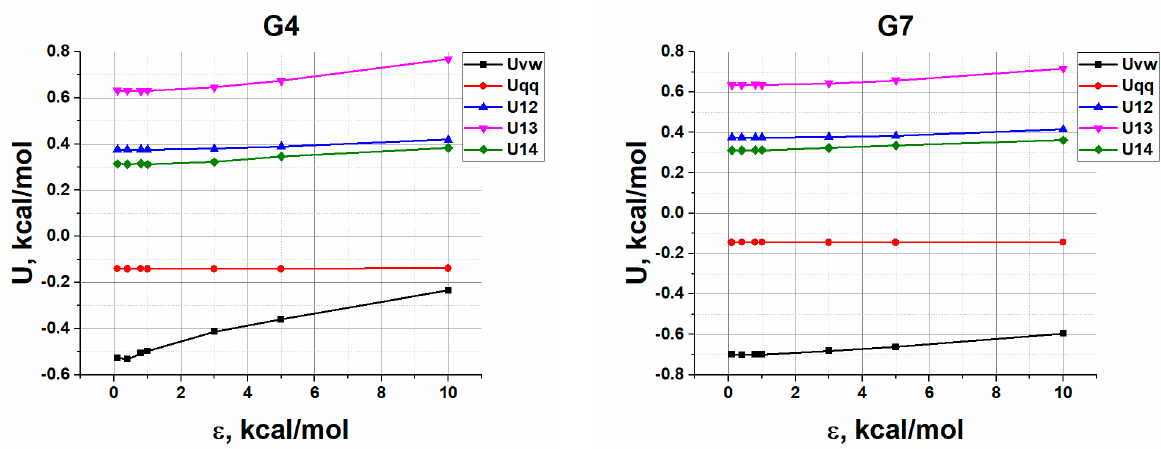
Figure 2. The dependences of the potential energy contributions per atom on the adsorption energy parameter ε calculated for the 4th and the 7th generations of C4-dendrimers. Here, Uvw is the energy of van der Waals interactions, Uqq is Coulomb energy due to partial charges, U12, U13, and U14 are the potential energies of bond, valence angles, and torsional angles, respectively.